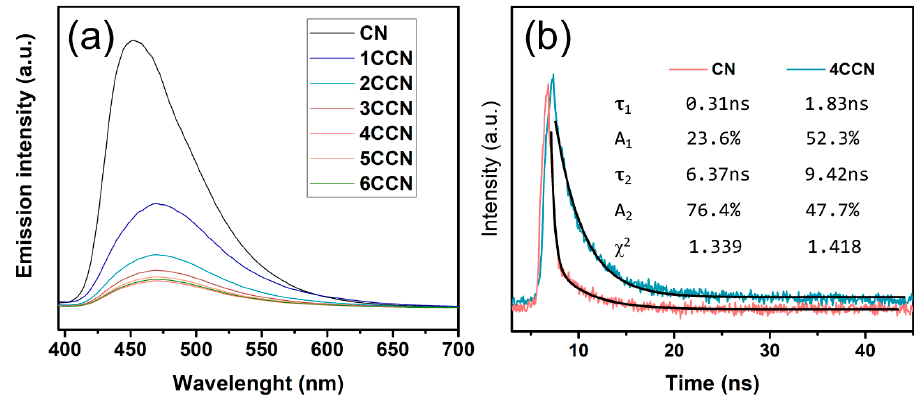
Figure6. Photoluminescencespectra( a )ofCNandCCNsamples, andtime-resolvedphotoluminescence Figure 6. Photoluminescence spectra ( a ) of CN and CCN samples, and time-resolved spectra (TRPL) ( b ) of the CN and 4CCN samples. photoluminescence spectra (TRPL) ( b ) of the CN and 4CCN samples .